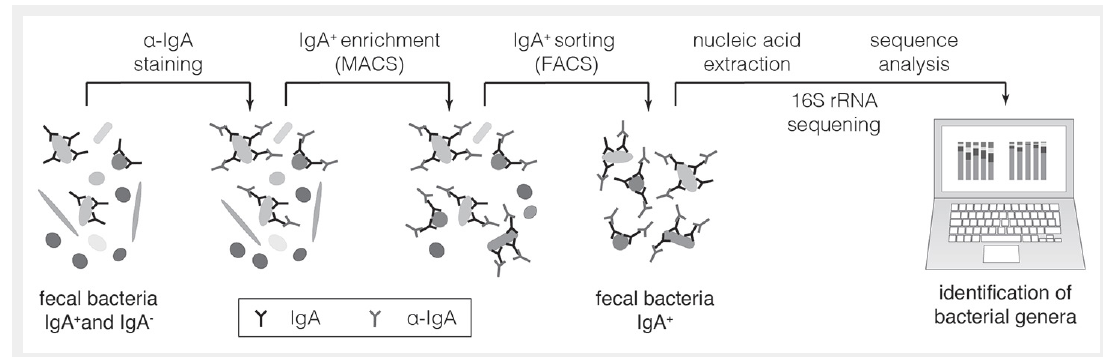
Identification of disease-associated bacterial consortia in the gut. The bacteria coated with IgA in faecal material can be labelled with an antibody directed against IgA. IgA-coated bacteria are then enriched by magnetic-activated cell sorting (MACS), purified by fluorescence- activated cell sorting (FACS) and sequenced by 16S ribosomal RNA sequencing to identify the IgA coated genera.